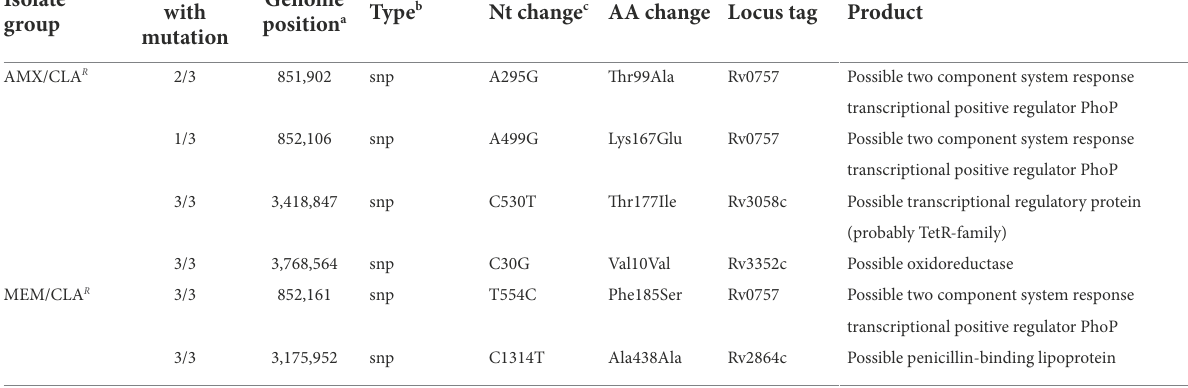
TABLE 4 Mutations and affected genes identified on Mtb isolates selected with beta-lactams.